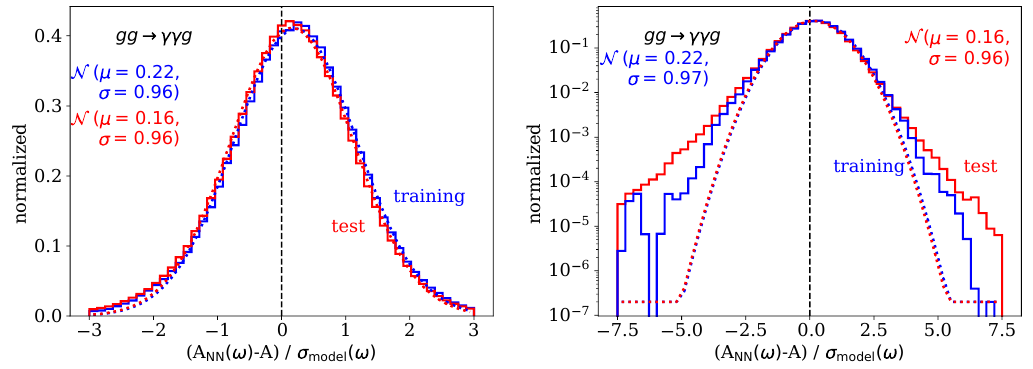
Figure 4: Weight-dependent pulls for the BNN, defined in Eq.(17) and evaluated on the training and test data. The two panels show the same curve on a linear and a logarithmic